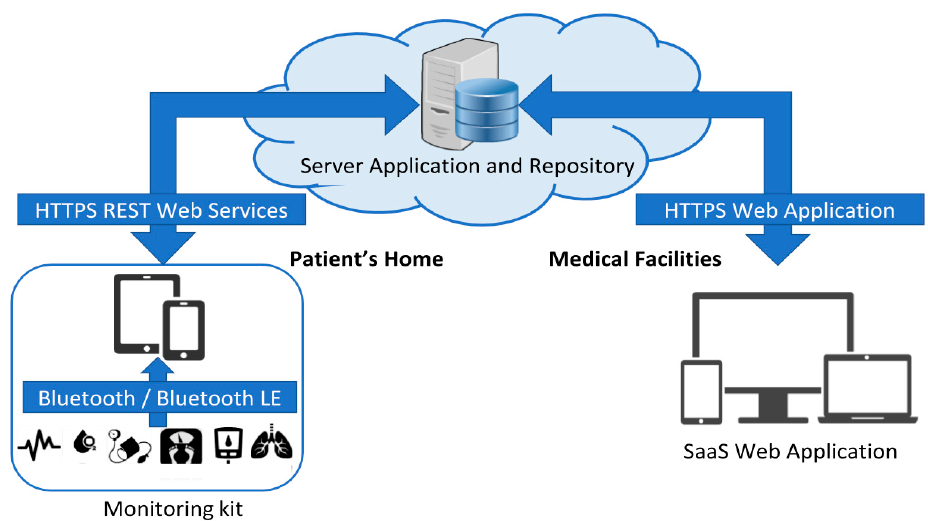
Figure 1. Architecture of the hardware/software system.